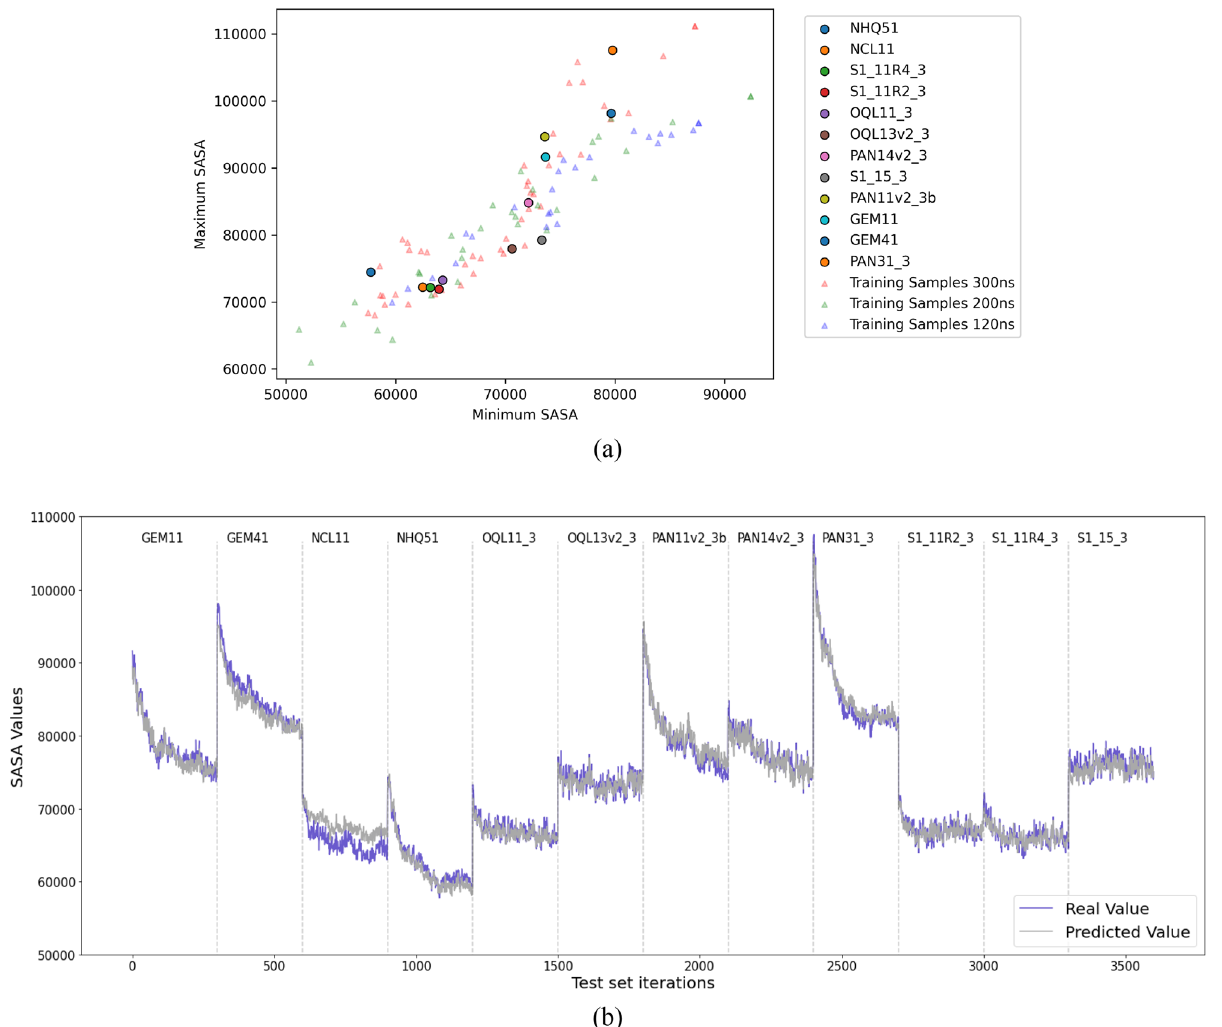
Figure 3. ( a ) The distribution of NP designs in the training and the test set based on the minimum and maximum SASA values. Each dot represents test data for a particular NP design, with the letters of the design name referring to the drug type and the remainder being a unique identifier. The training samples are represented by triangles and grouped by their sizes. ( b ) Visualization comparing the real and predicted SASA values of different NP designs (separated by dashed lines) from the test set over 300 iterations each. The blue line represents the actual SASA value, and the grey line represents the predicted SASA value. Window size, w